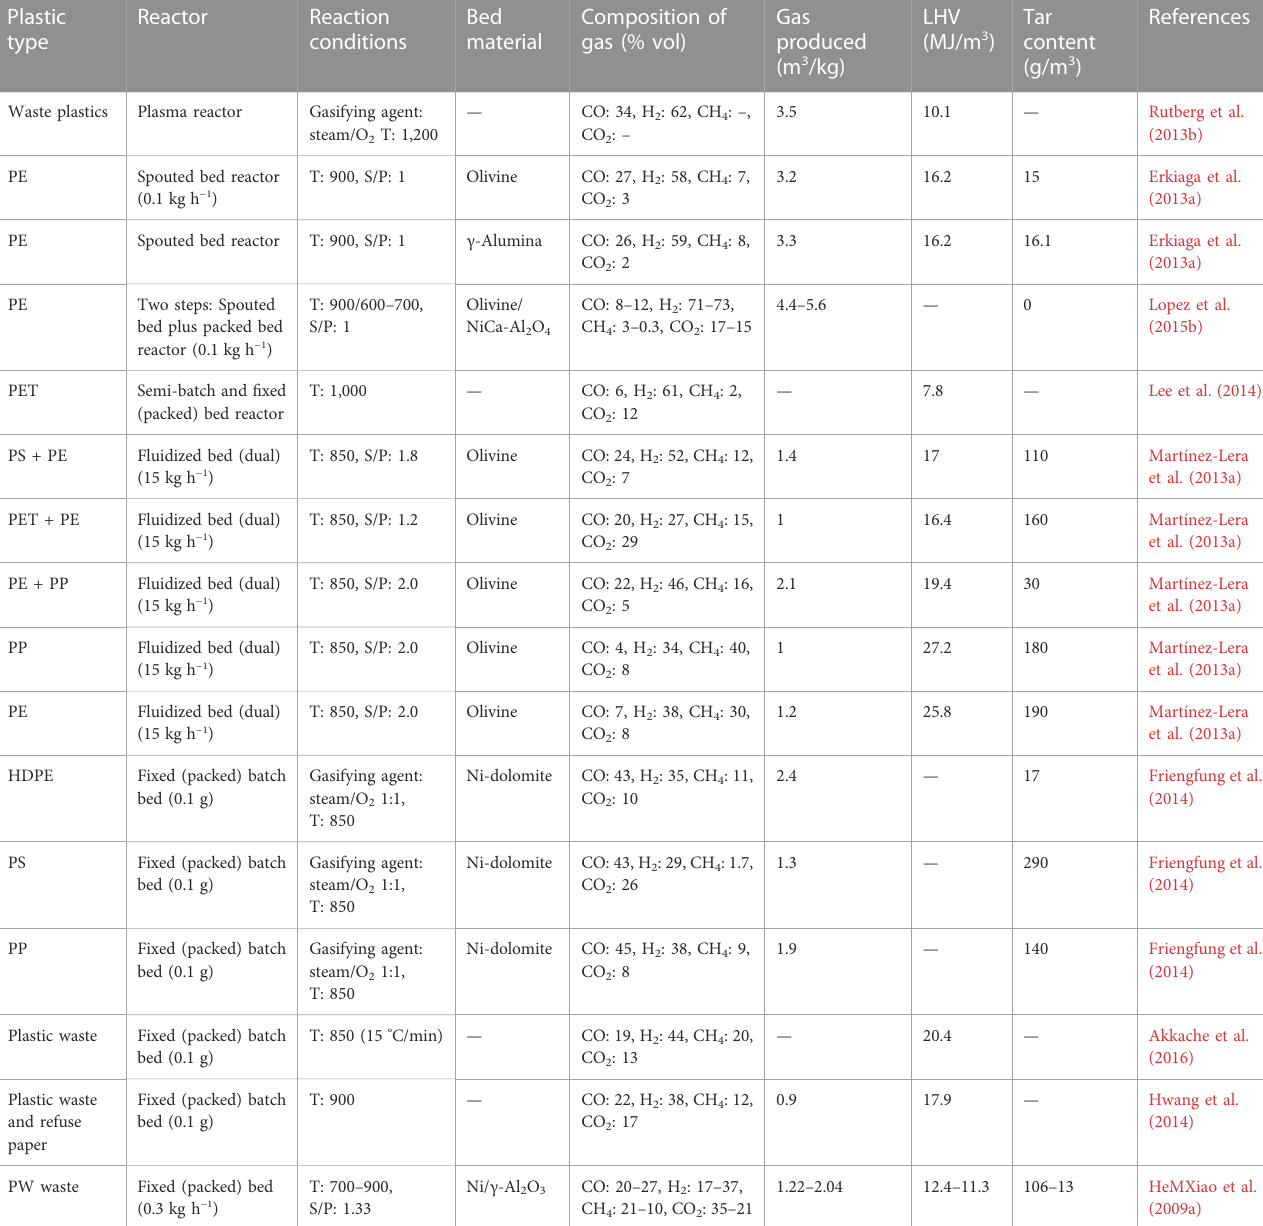
TABLE 1 Different gas compositions obtained by authors in steam plastics waste gasi fi cation. Plastic type